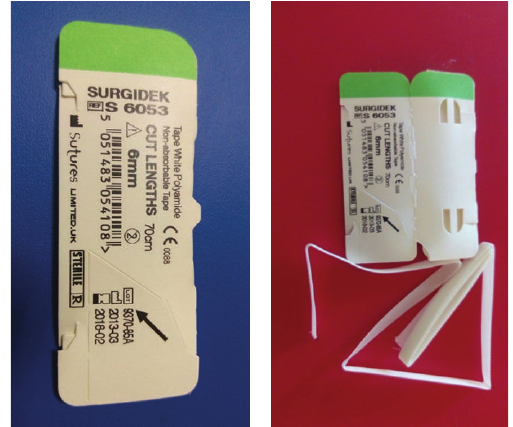
Figure 3: Polyamide nonabsorbable type.